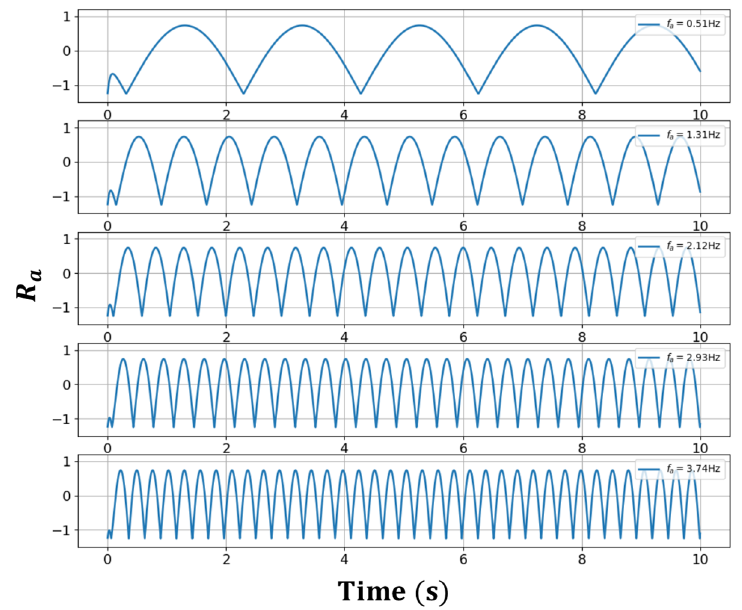
Figure 2. 𝑹 𝒂 within the lock-in area. Figure 2. R a within the lock-in